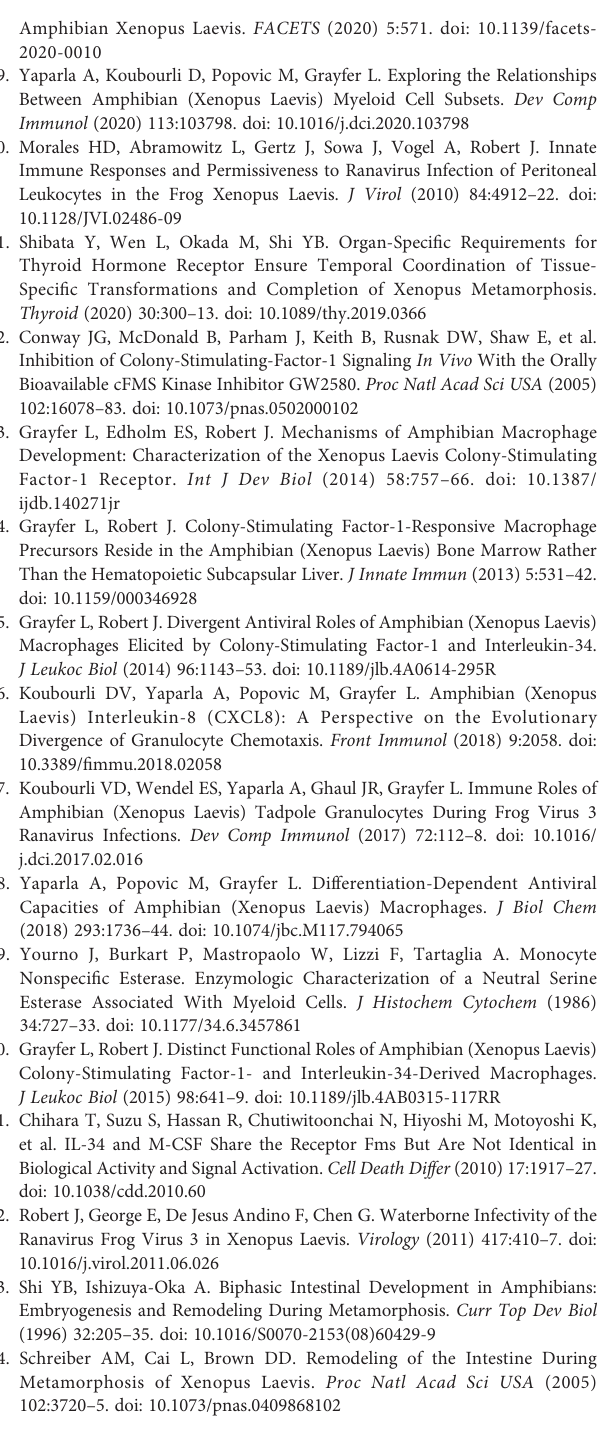
muscularis layers. Images are representative of results derived with 5 individual animals per treatment group. Supplementary Figure 2 | Analyses of (A) CC- and (B) CXC-motif chemokine genes in mock- and FV3-infected tadpole intestines. (C) Comparison of ccl20 expression in mock- and FV3-challenged tadpole and adult intestines. Results are means ± SE of gene expression relative to gapdh endogenous control ( N =6).